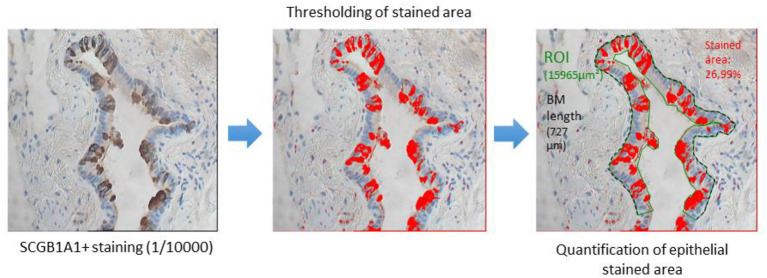
After SCGB1A1 staining, small airway epithelia were isolated via thresholding, perimeters, thickness/height, and by the area quantified.